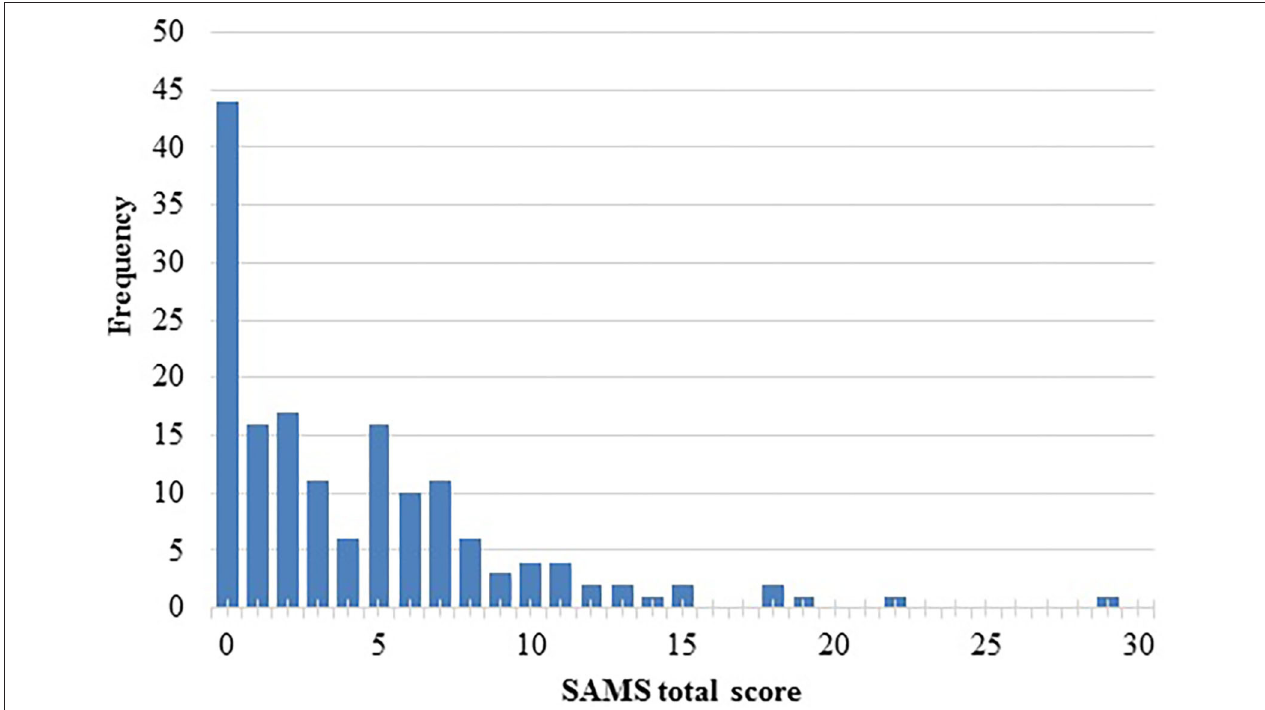
FIGURE 1 | Distribution of Stendal Adherence to Medication Score (SAMS) total